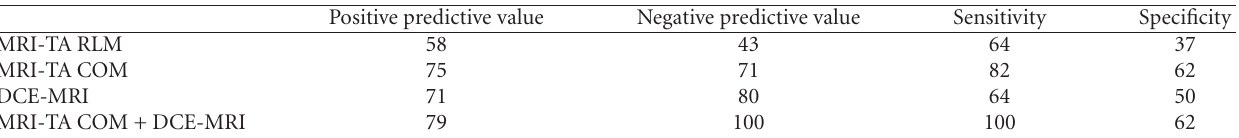
Table 3: Positive predictive value, negative predictive value, sensitivity and specificity (in %) obtained from hierarchical ascendant classifica- tion of both MRI-texture analysis run length matrix parameters (RLM) and co-occurrence matrix parameters (COM) and dynamic contrast enhancement MRI parameters for in vivo discrimination of MGNT from glioblastoma